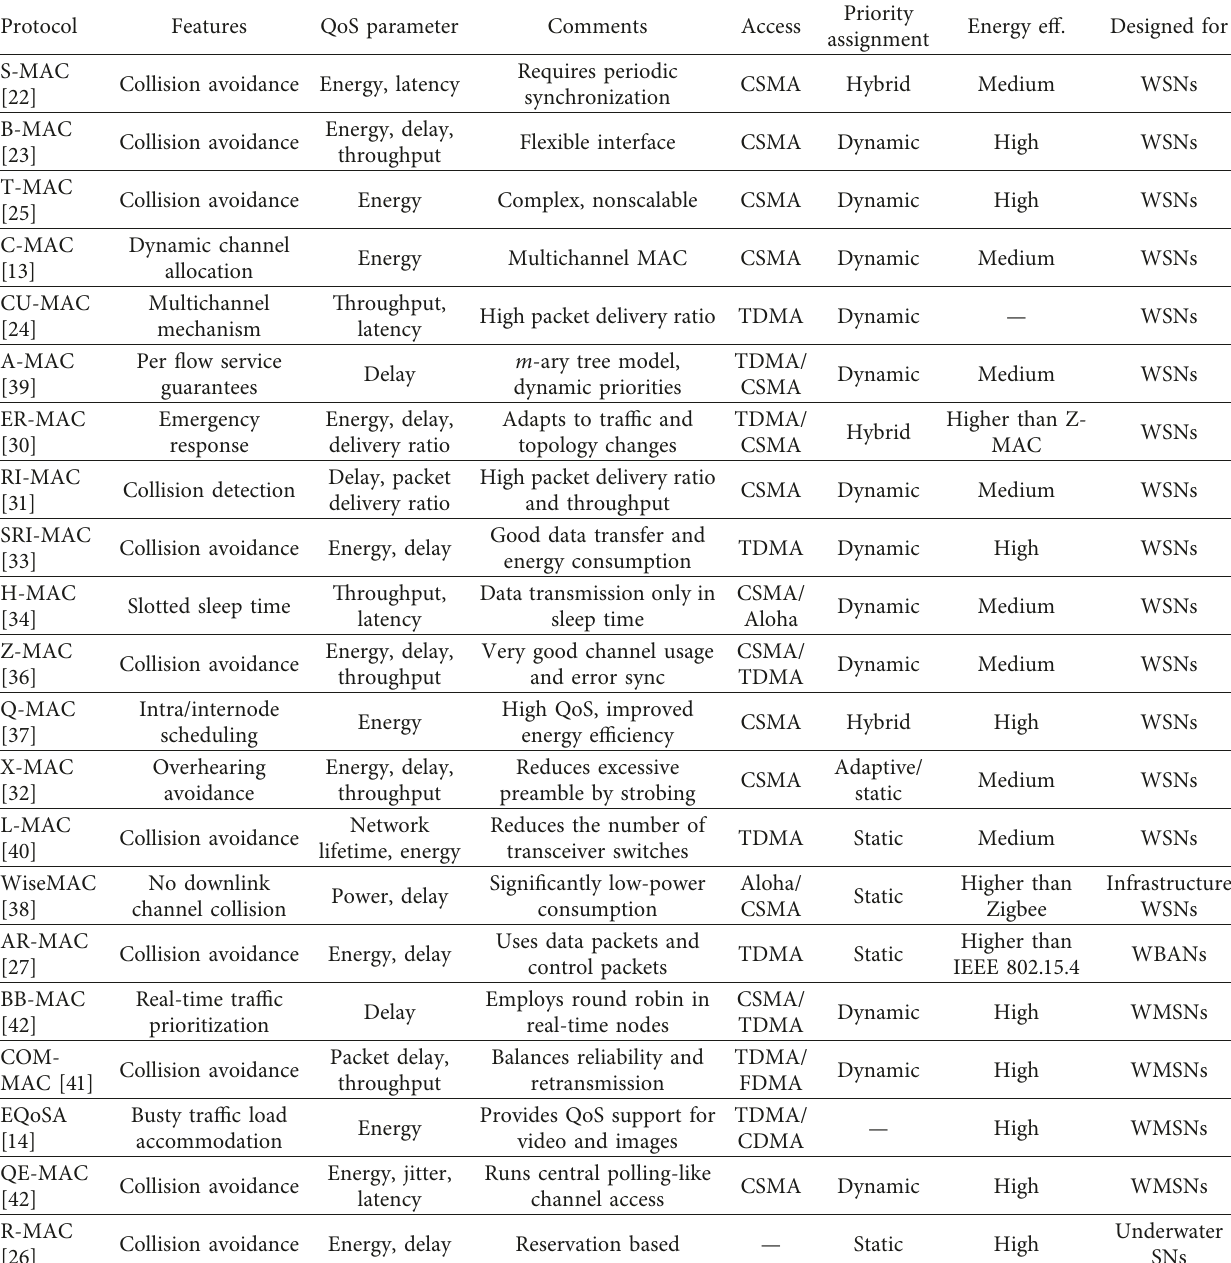
Table 2: Comparison of MAC layer protocols used in QoS